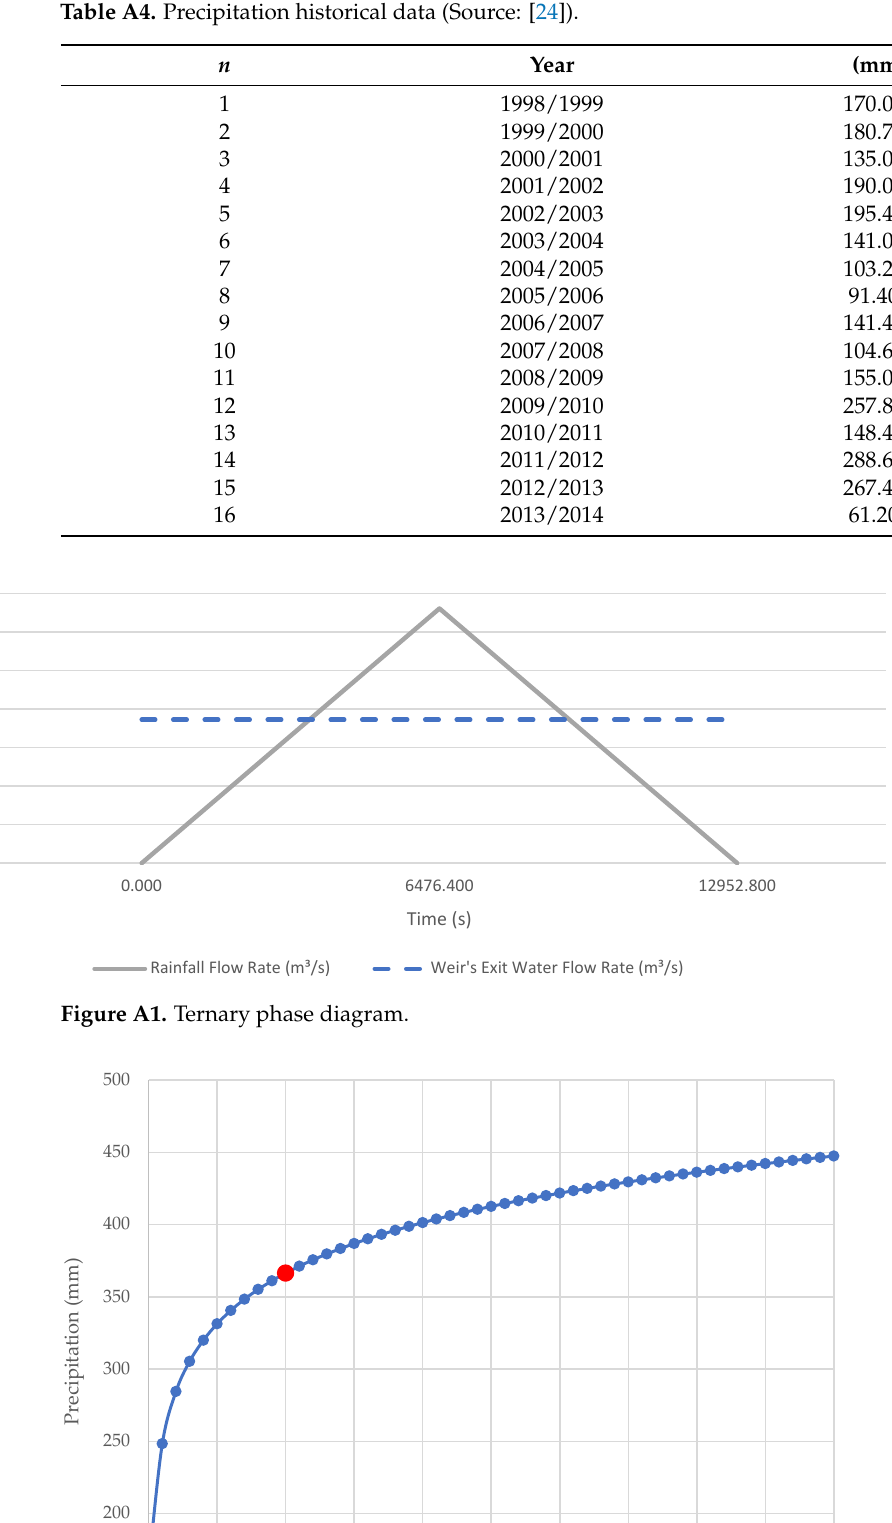
Table A4. Precipitation historical data (Source: [24]).